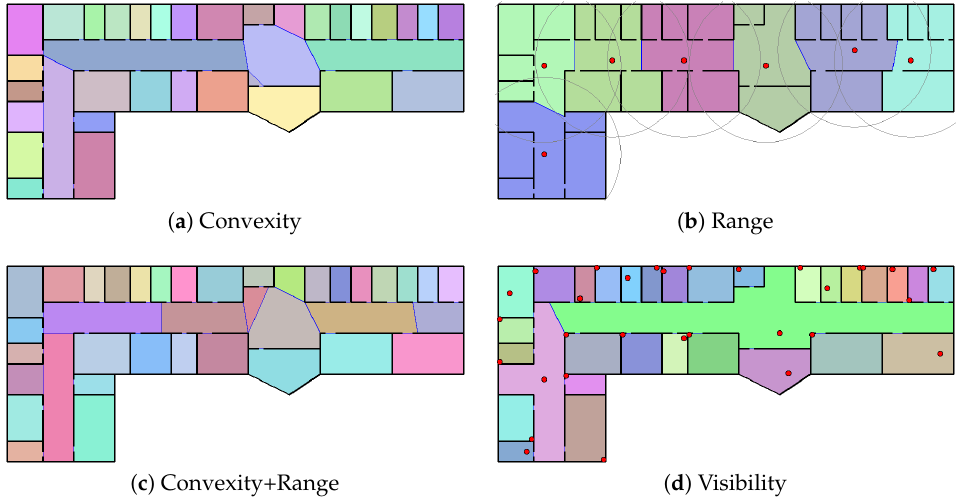
Figure 11. Partitioning with different